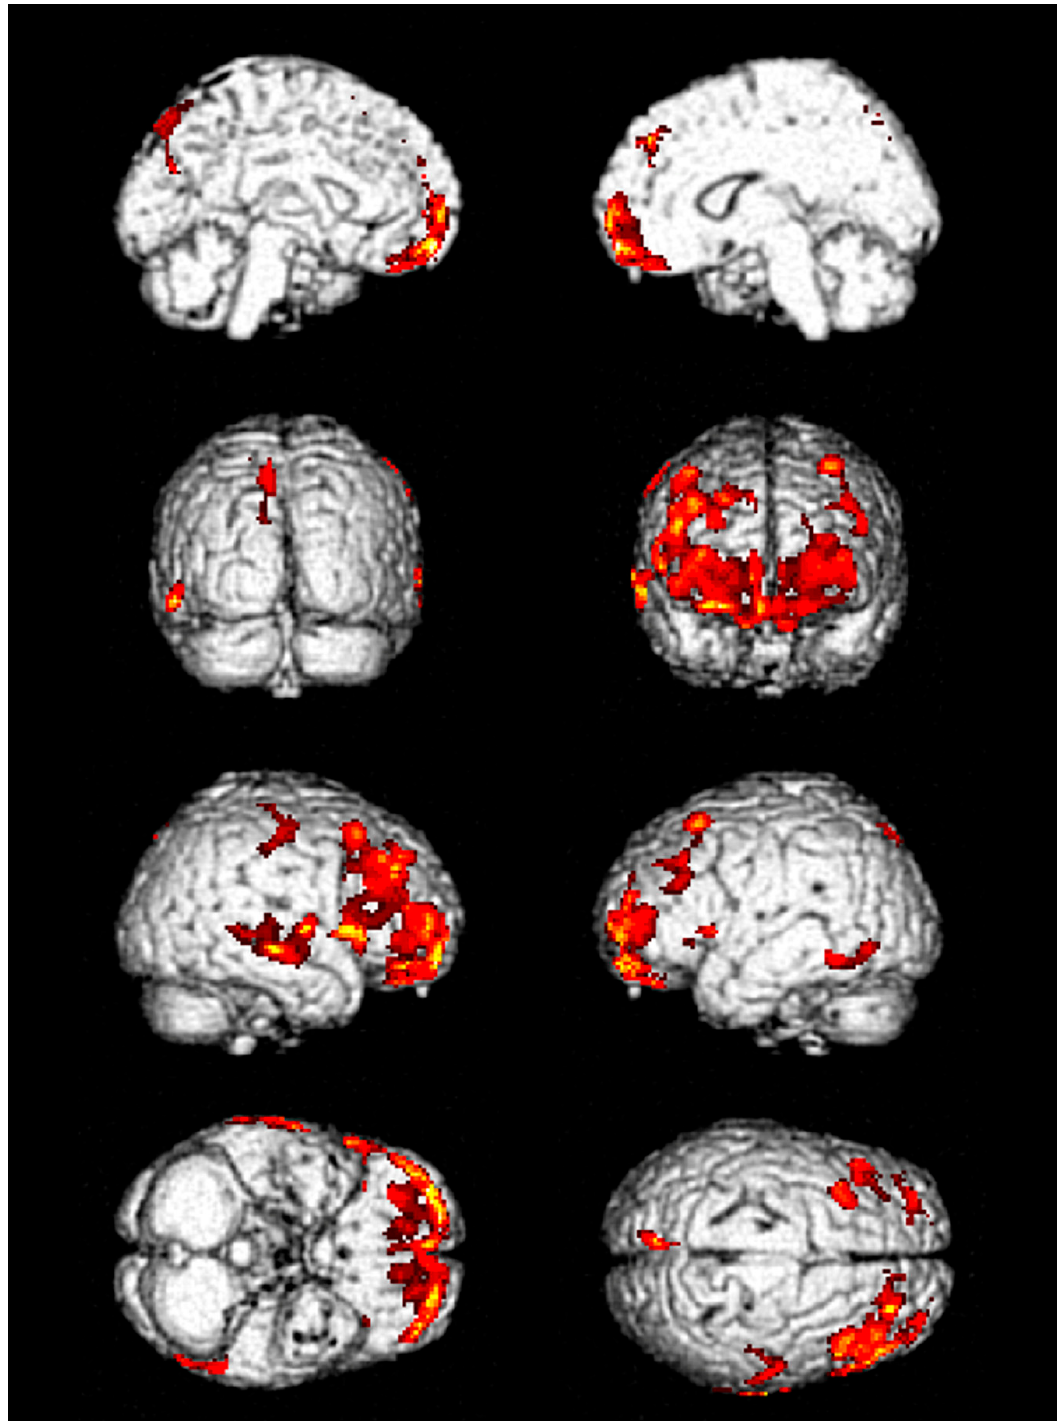
Figure 2. The results of group analysis of brain FDG PET/CT. Three age- and sex-matched patients were selected from the healthy subject group at a 1:3 ratio after pseudo-randomization and then compared to the patients with glufosinate ammonium intoxication to assess the alteration in glucose metabolism. The areas colored with red in the figure showed decreased FDG uptake in PET images of nine patients compared to the PET images of matched healthy control subjects. Nine intoxicated patients revealed significantly decreased glucose metabolism in the frontal and temporal cortex.